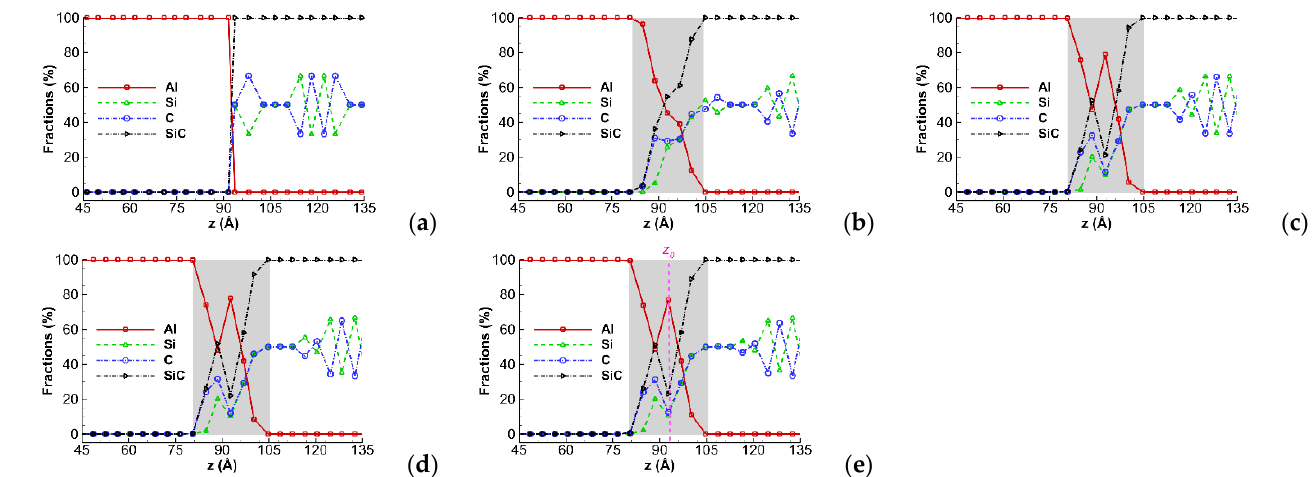
Figure 4. Concentration profiles of Al, Si, and C atoms along the z -direction during interdiffusion of the C-terminated 6H–SiC/Al interface. The grey zone in the figures indicates the diffusion zone and its thickness. ( a ) Atomic structure at 300 K before relaxation and the configuration after maintaining the system at 2000 K for ( b ) 0 ns, ( c ) 2 ns, ( d ) 4 ns, and ( e ) 6 ns.